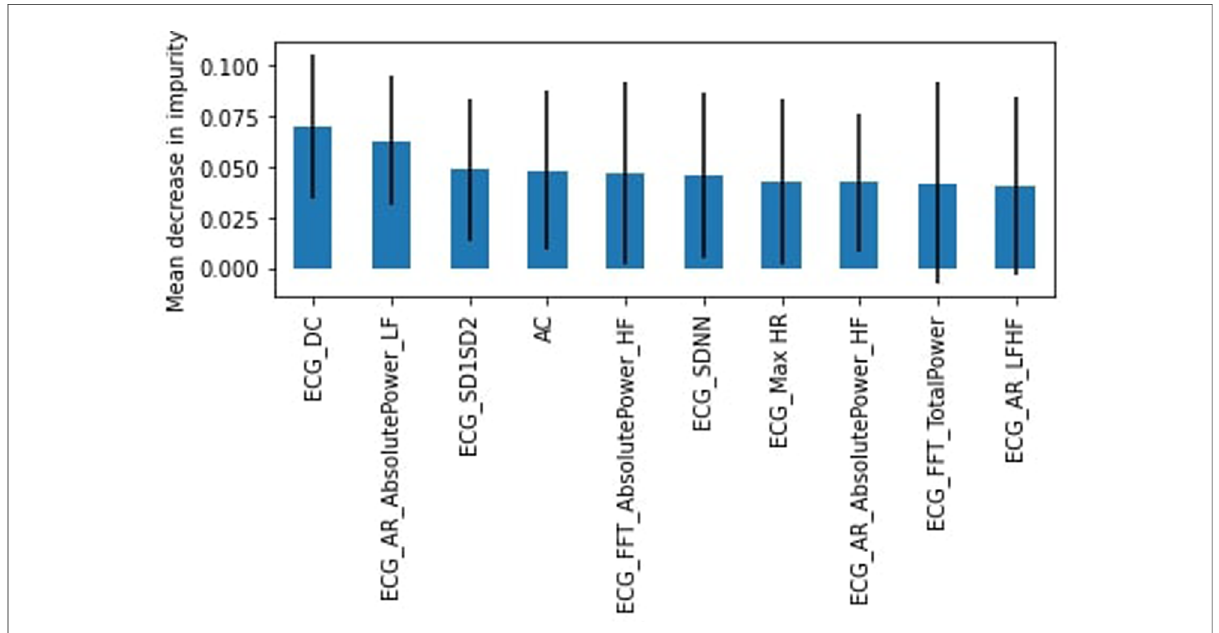
FIGURE 14 RF feature importance, medium and high SES